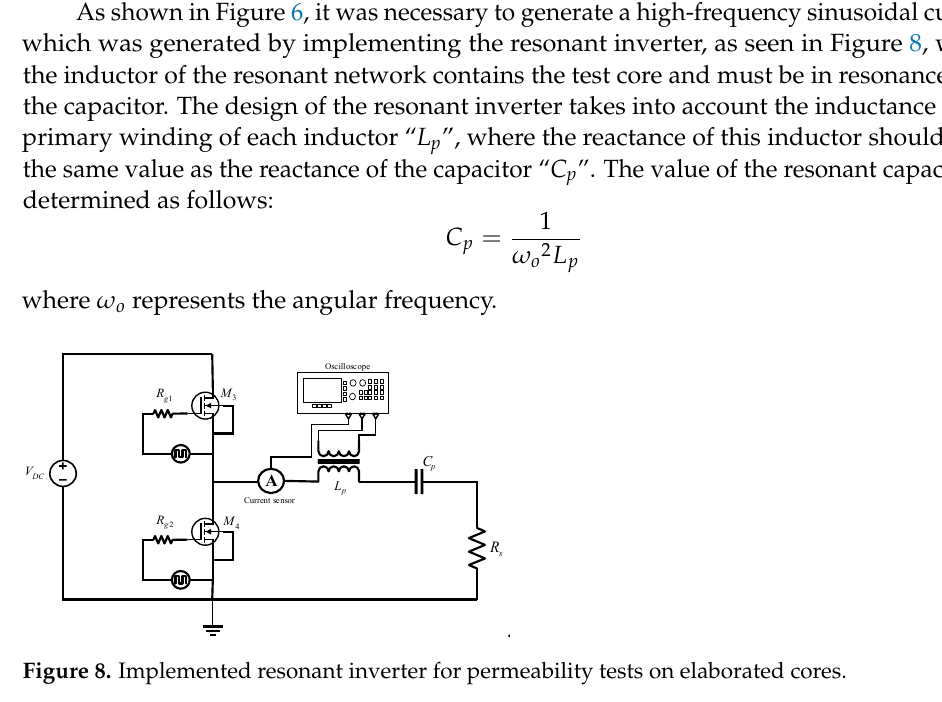
Figure 8. Implemented resonant inverter for permeability tests on elaborated cores. In order to determine the relative permeability of the cores that were made using the ASTM A772/A772M standard, it was necessary to do some circuit measurements such as the RMS current flowing in the primary winding and the RMS voltage induced in the secondary winding. These values were measured with a digital oscilloscope as shown in Figure 8. With the corresponding measurements, it is possible to determine the maximum magnetic flux density “ B max ” and the maximum magnetic field intensity “ H max ”, defined as